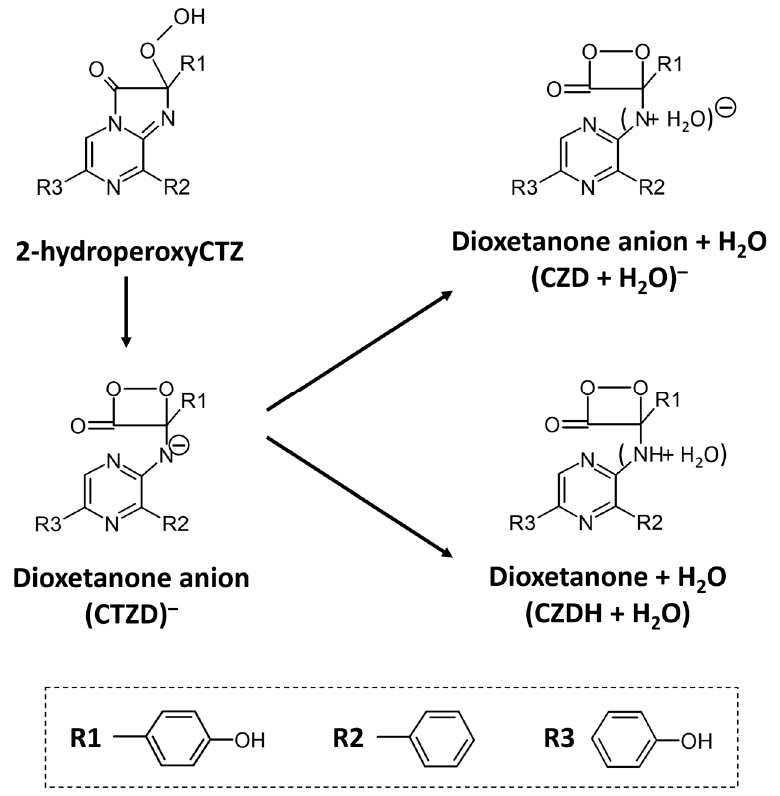
Figure 7. Dioxetanone derivatives that might be formed in bioluminescent reaction of hydromedusan photoproteins.